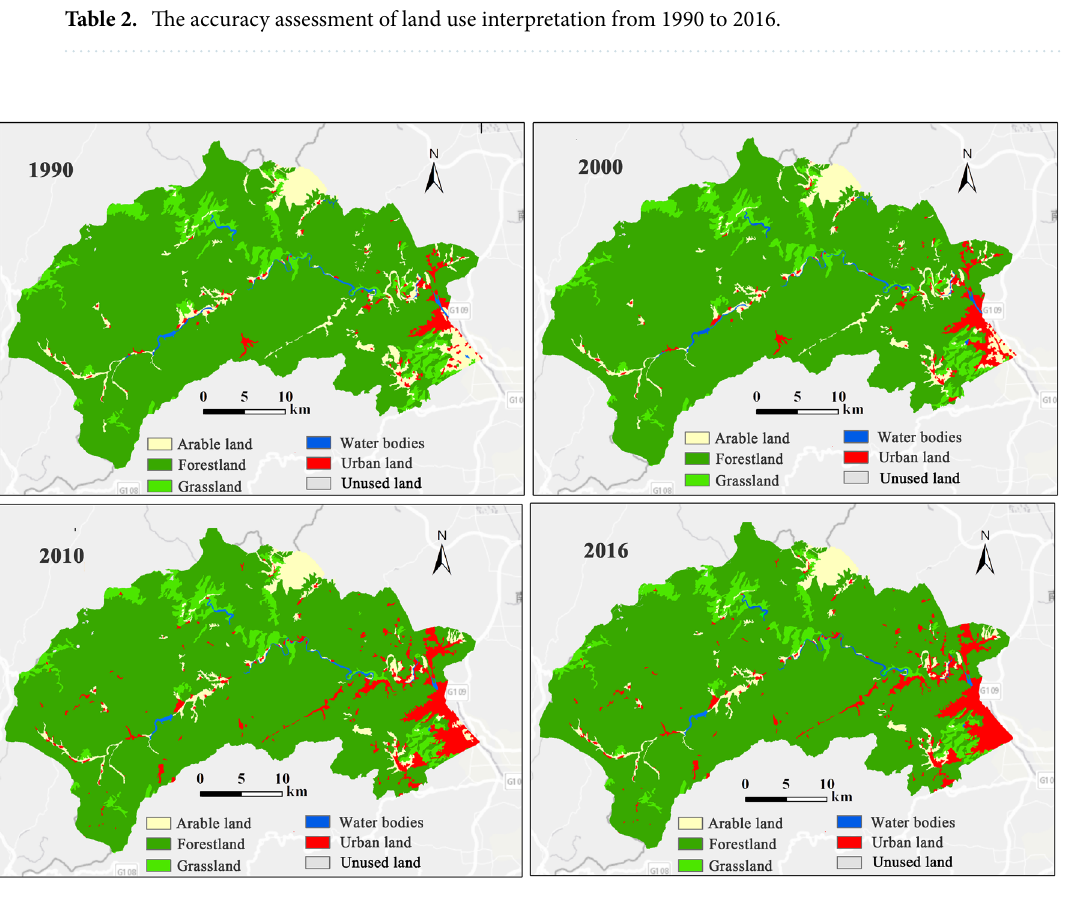
Figure 2. Land cover maps in Mentougou from 1990 to